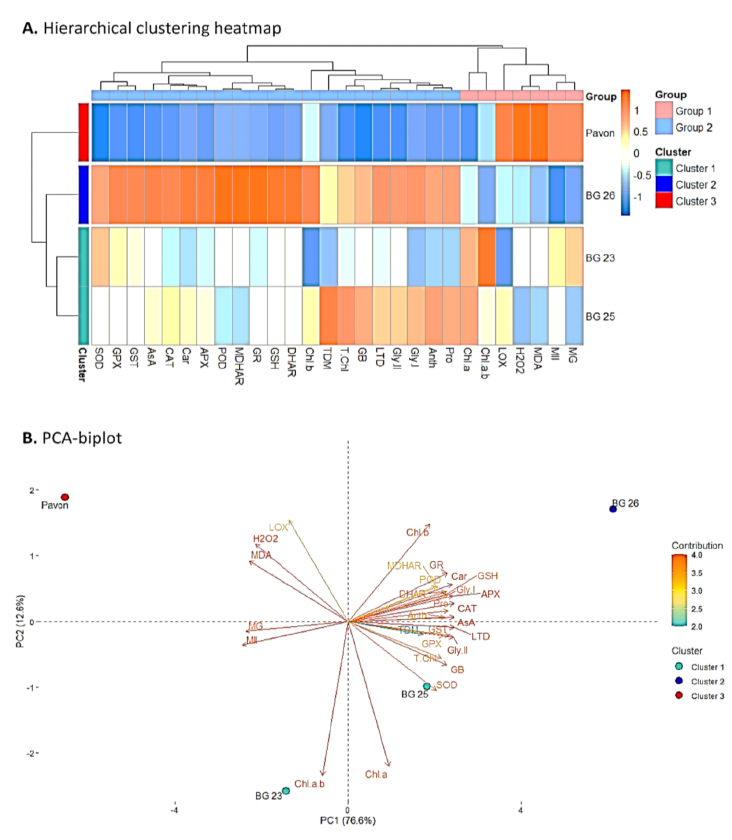
Figure 8. Hierarchical clustering and PCA-Biplot indicates an association between treatments, vari- ables and varieties. ( A ) Hierarchical clustering heatmap: The STI (Stress Tolerance Index) mean values obtained from the studied variables of all varieties, which were then normalized and clustered. Two distinct groups were obtained at the variable levels (Group-1 and 2) ( B ) for all varieties. Different color scale expresses the intensity of the normalized mean values of various variables. PCA-Biplot: Varieties dispersed in different ordinates based on the dissimilarity among them. The length and color intensity of a vector in the biplot indicate the quality of representation and the contribution of the variable on the principal component, respectively. The angles between the vectors derived from the middle point of biplots exhibit positive or negative interactions among the variables. The variables included LTD, leaf temperature depression; MII, membrane injury index; MG, methyl- glyoxal; MDA, malondialdehyde; LOX, lipoxygenase; H 2 O 2 , hydrogen peroxide; Pro, proline; GB, glycine betaine; TDM, total dry matter; STI, stress tolerance index; GSH, glutathione; AsA, ascorbate; “Chl a”, chlorophyll a; “Chl b”, chlorophyll b ; T.Chl, total chlorophyll; Chl.a.b, chlorophyll a/b;